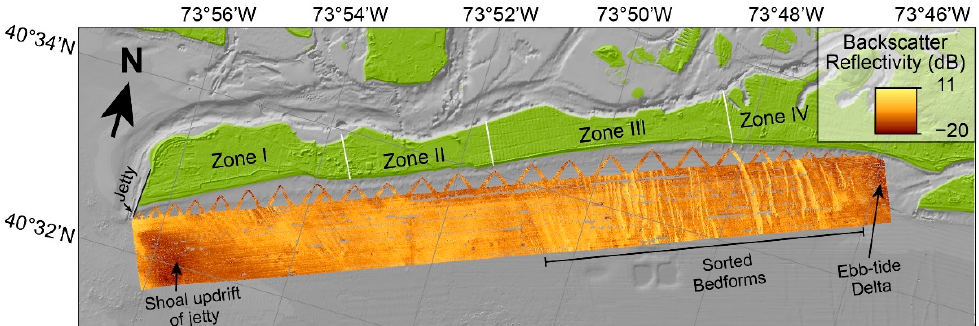
Figure 5. Multibeam backscatter. High reflectivity (bright colors) generally corresponds to harder seafloor substrate or increased roughness, whereas low reflectivity (dark colors) generally corresponds to softer substrate. White lines on the peninsula delineate the boundaries of the geomorphic zones..